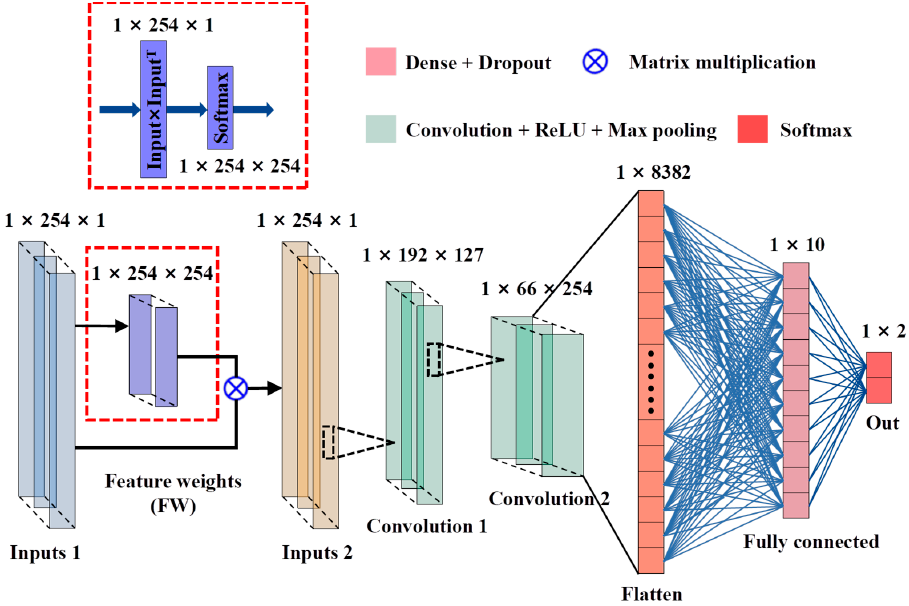
Figure 5. Architecture of CNN-FES module.